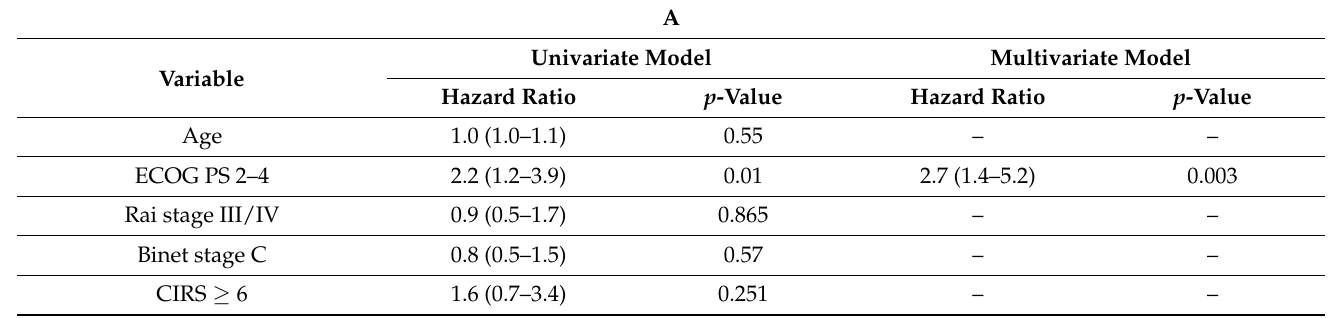
Figure 3. Kaplan–Meier plot showing the progression-free survival and overall survival curves according to the ECOG performance status (PS) score (( A1 ) and ( B1 ), respectively) and time from initiation of the last treatment (TILT) before ibrutinib (( A2 ) and ( B2 ), respectively). Abbreviations: ECOG, Eastern Cooperative Oncology Group; TILT, time from initiation of the last treatment (before ibrutinib). Table 5. Univariate and multivariate analysis of baseline risk factors on progression-free survival ( A ) and overall survival ( B ) in the R/R CLL